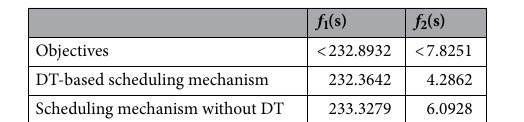
Table 9. Performance analysis and comparison of different scheduling